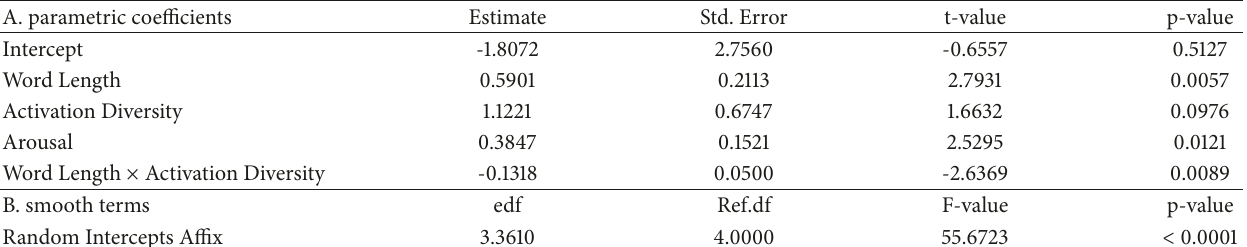
Figure 4: Interaction of word length by activation diversity in GAMs fitted to plausibility ratings for complex words (left) and to semantic transparency ratings (right). Table 3: GAM fitted to plausibility ratings for derivational neologisms with the derivational lexomes able, again, agent, ist, less, and not; data from Marelli and Baroni